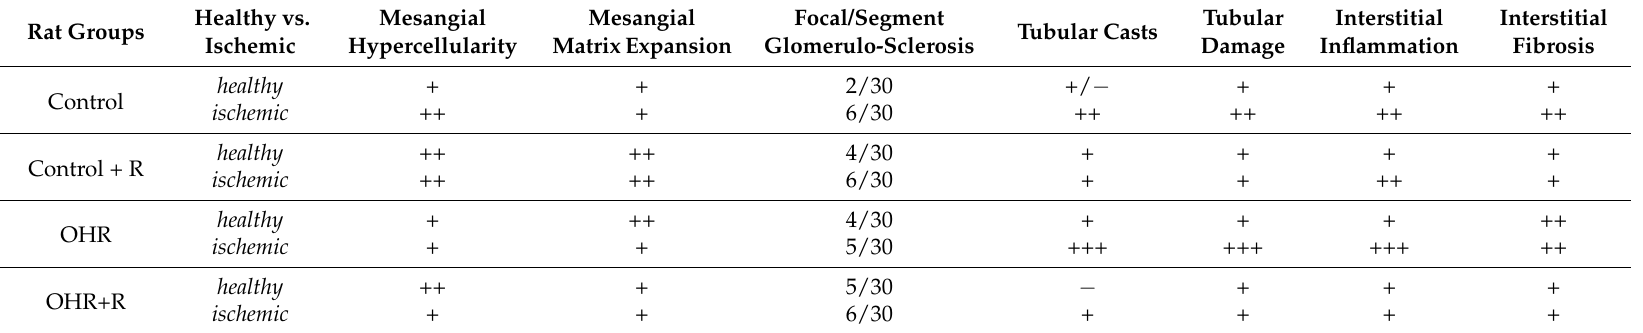
Table 3. Histological evaluation on contra-lateral healthy and ischemic kidney of control and OHR